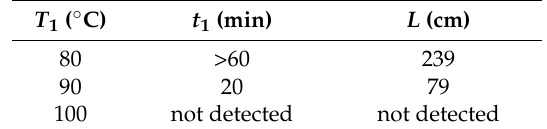
Table 1. The relationship between gelation time and gelation temperature.